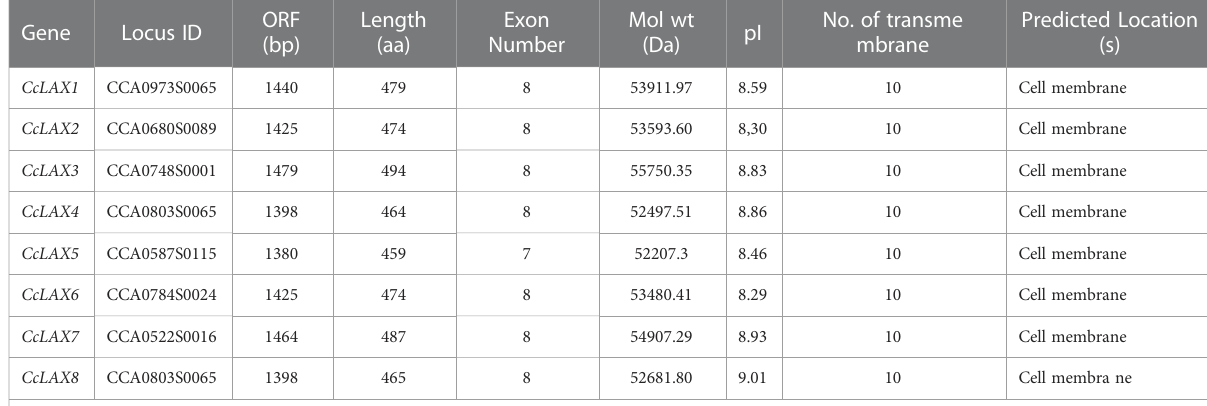
TABLE 1 The physical and chemical properties of AUX/LAX family proteins in Chinese hickory.